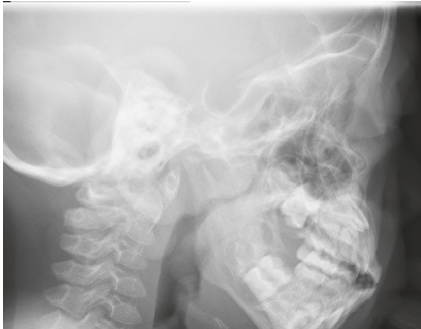
Figure 2: Lateral neck X-ray. Obstruction of the nasopharyngeal airway due to adenoid hypertrophy is apparent.